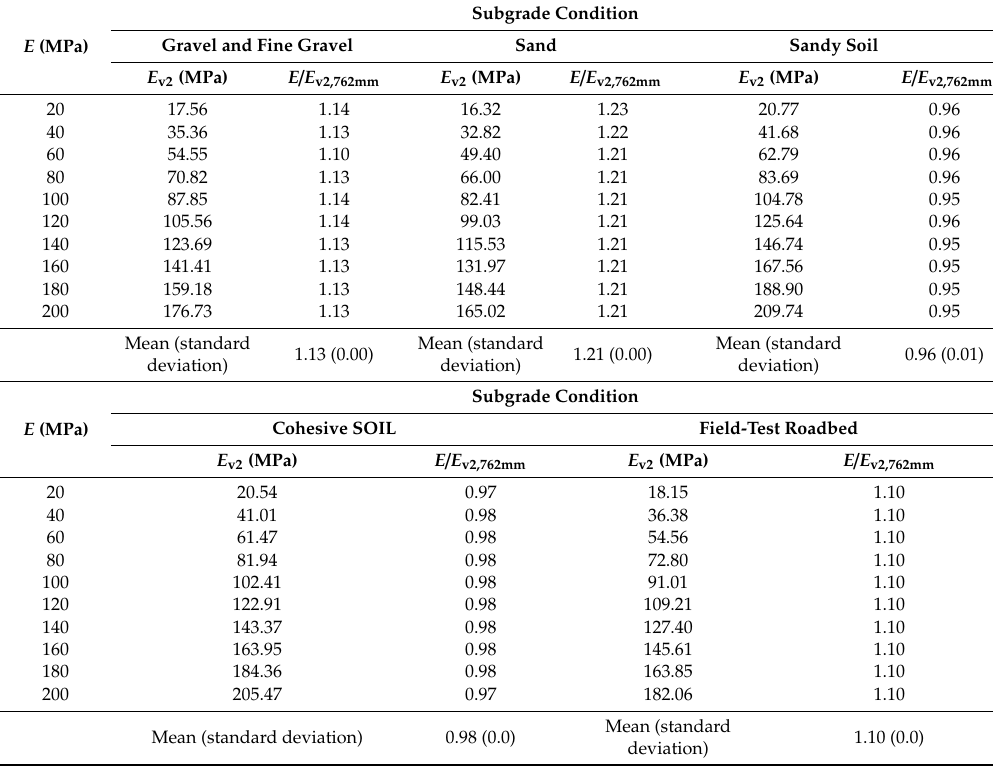
Table 8. Relationship between the elastic and subgrade strain moduli (762-mm loading plate) according to the subgrade condition.